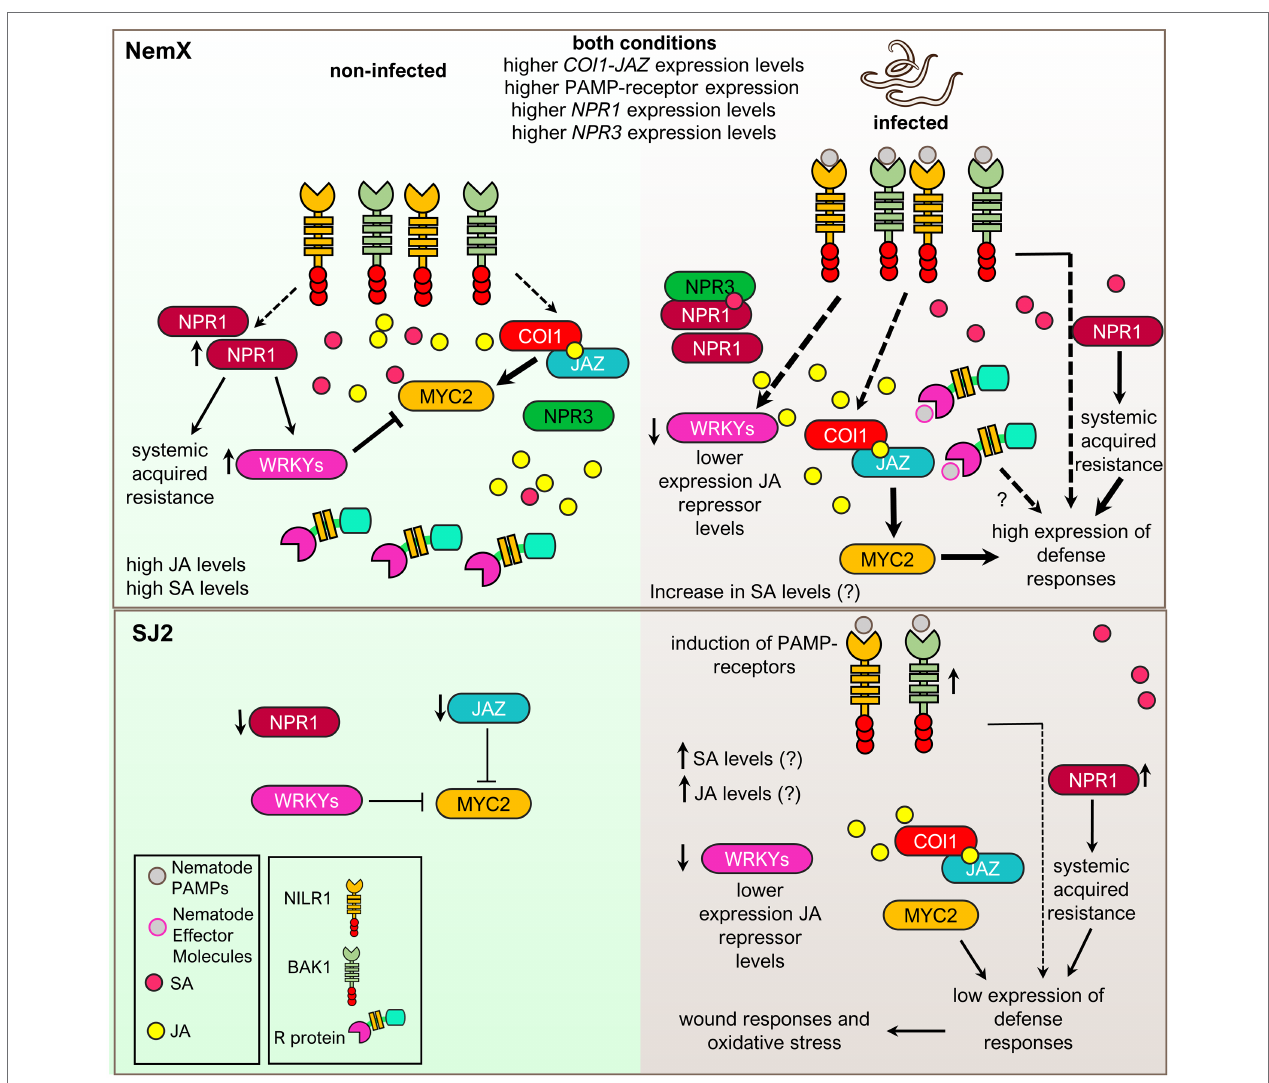
FIGURE 8 | Putative model that explains RKN-resistance in the NemX cultivar at the molecular level. The model depicts putative molecular mechanisms that occur in RKN-resistant NemX (upper panel) and RKN-susceptible SJ2 (lower panel) in response to RKN-infection (right). NemX presents higher basal levels of salicylic (SA) and jasmonic acid (JA) defense-related phytohormones than SJ2. Enhanced expression of the salicylic acid master regulator NPR1 and the salicylic acid co-receptor NPR3 results in enhanced expression of genes related to systemic acquired resistance. Enhancement of WRKY expression, most likely caused by enhanced basal levels of salicylic acid and NPR1 signaling, antagonizes jasmonic acid signaling but the enhanced basal levels of jasmonic acid and the expression of jasmonic acid signaling components remain high which might protect the plant in the case of RKN infection. It is likely that this constitutive expression of jasmonic and salicylic acid signaling genes is caused by enhanced basal levels of these phytohormones and the constitutive expression of RLKs and R proteins in NemX. In SJ2, this mechanism of resistance is not present, and the root presents lower basal expression of defense signaling genes. In NemX, RLKs and R proteins have a higher expression level and likely detect nematode pathogen associated molecular patterns (PAMPs) and nematode effector molecules, respectively, to trigger high levels of defense transcriptional responses which constitutively prevent RKN invasion and egg deposition. In the case of SJ2, RLK and R protein receptors have a lower basal level expression and are mildly induced to a lower level than in NemX in response to RKN infection which correlates with lower levels of expression of defense- related genes which results in a more successful RKN infection in SJ2 than in NemX. The successful RKN-infestation in SJ2 leads to the expression of wound and oxidative stress responses related to cellular death and